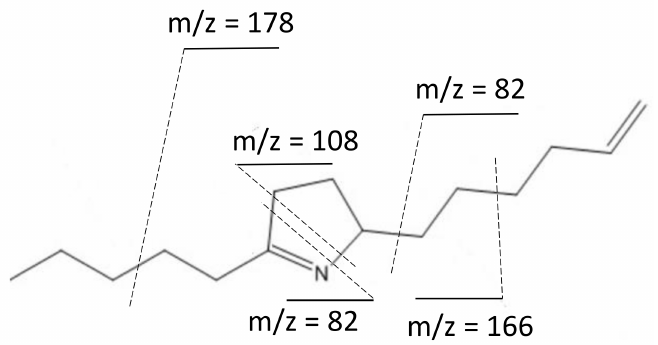
Figure A2. Suggested occurences of cleaving of the C 2 molecule with the corresponding m / z of the generated ion.